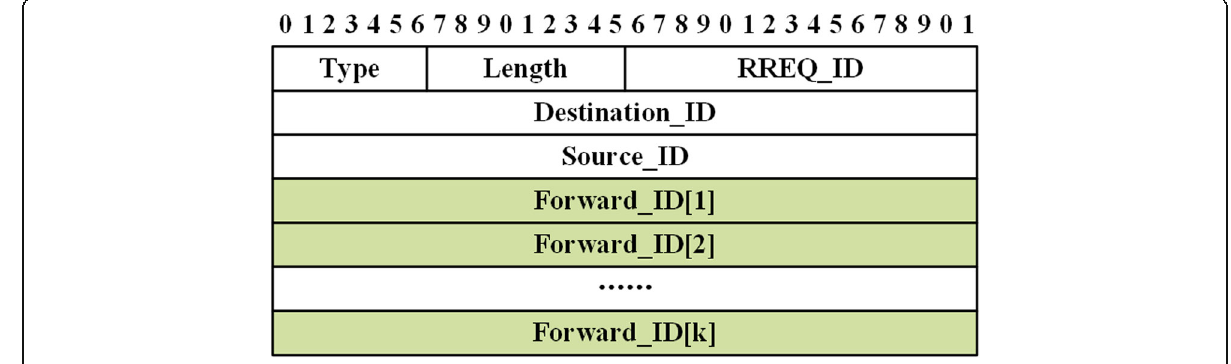
Fig. 12 Structure of RREQ message. Figure 12 shows the structure of RREQ message, including the name of fields and their